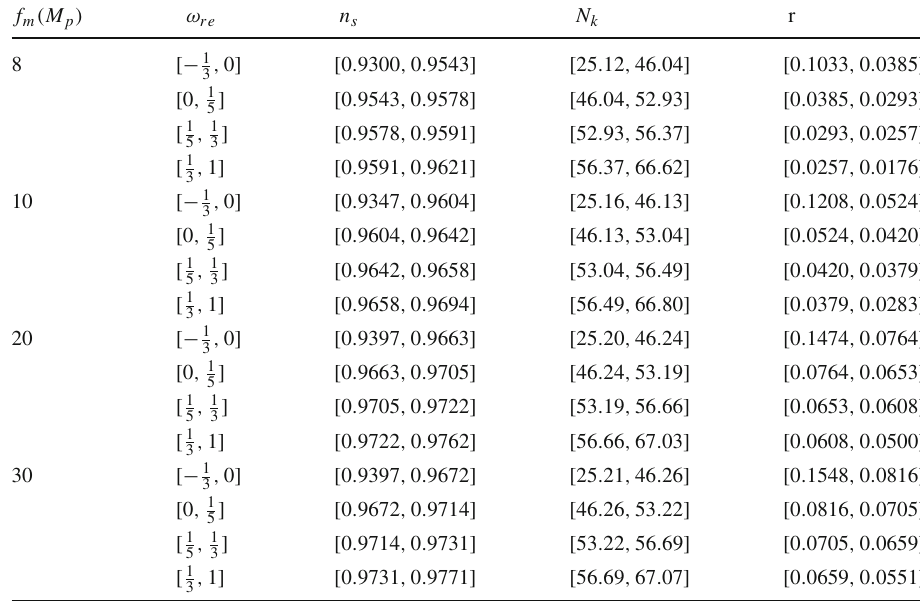
≤ ω ≤ 1, and ω ≥ 1 corresponds to the dark pink range re re 5